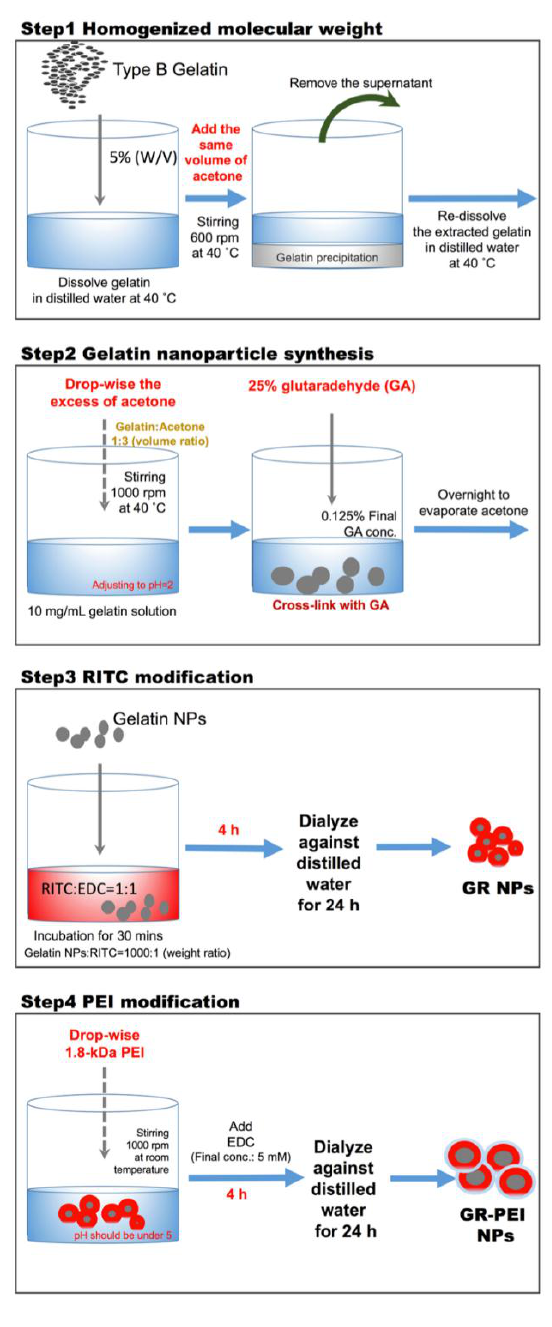
Figure 8. Scheme of particle synthesis.